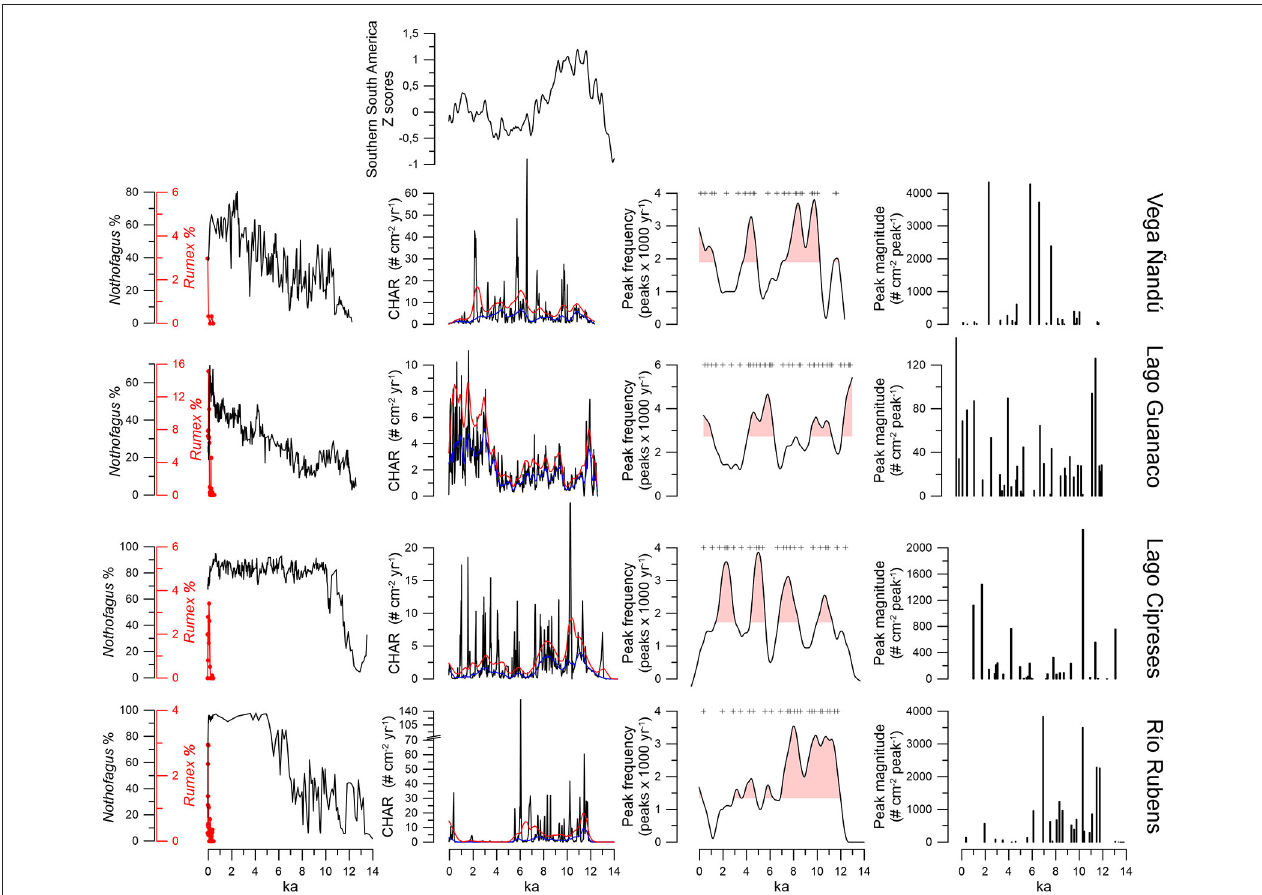
FIGURE 4 | Comparison of the Nothofagus and Rumex percentages from Lago Cipreses, Lago Guanaco, Vega Ñandú, and Río Rubens, along with their corresponding macroscopic charcoal records and results of CharAnalysis. The black line corresponds to CHAR, the blue line denotes the calculated background, and the red line a locally defined threshold value. The red filling denotes frequency values above the mean in each site, the + symbol represents statistically significant charcoal peaks, the histogram indicates the magnitude of the statistically significant charcoal peaks. Also shown is the charcoal synthesis curve from southern South America normalized to the modern (1–0.1 ka interval)